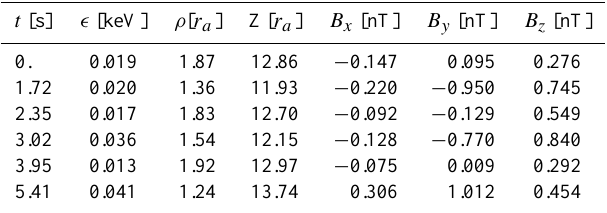
Fig. 4b. Spectral analysis of the B z signal, recorded at the point (x, y) = (11.5, 11.4) r a , and plotted in red in Fig. 4a. In the top right, the spectrum accumulated during 3s is shown and below, the corre- sponding spectral components intensities are plotted versus time. Table 2. Time, energy, position and magnetic induction along the dusk- electron